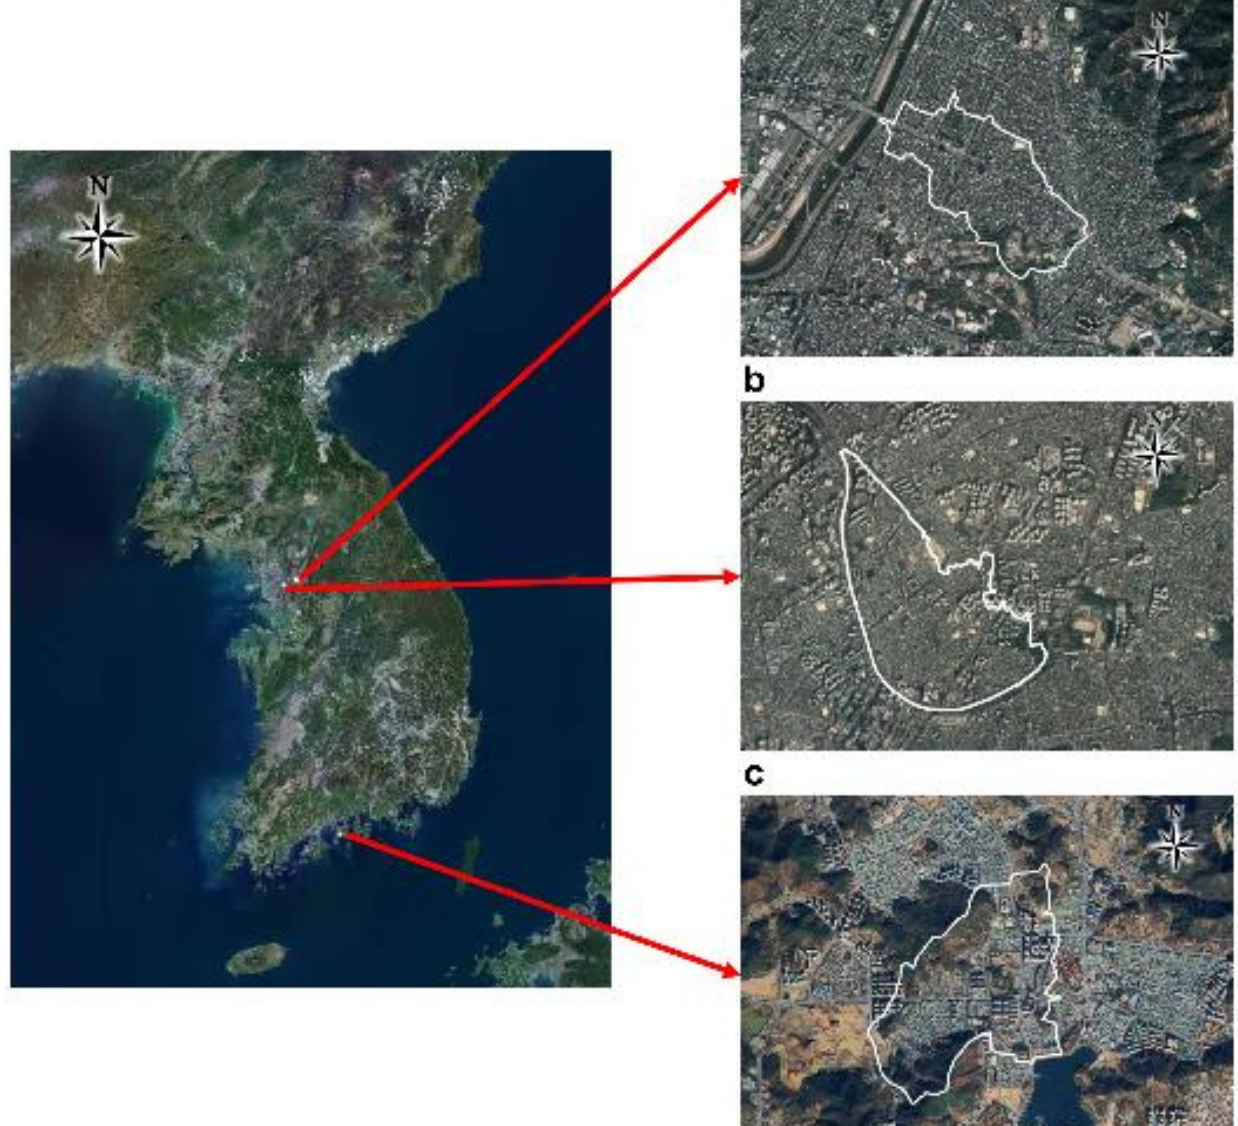
Figure 3. The watersheds selected for this study. ( a ) Gunja, ( b ) Dorim, and ( c ) Dowon watersheds in Seoul, South Korea.